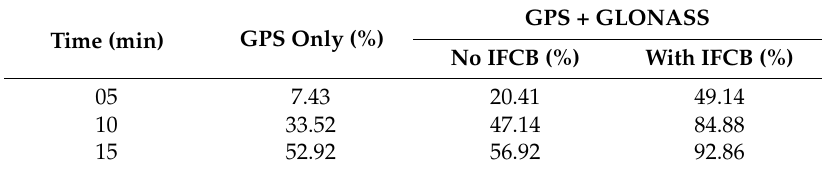
Table 4. Fixing percentage for various observation durations for kinematic PPP with different strategies.